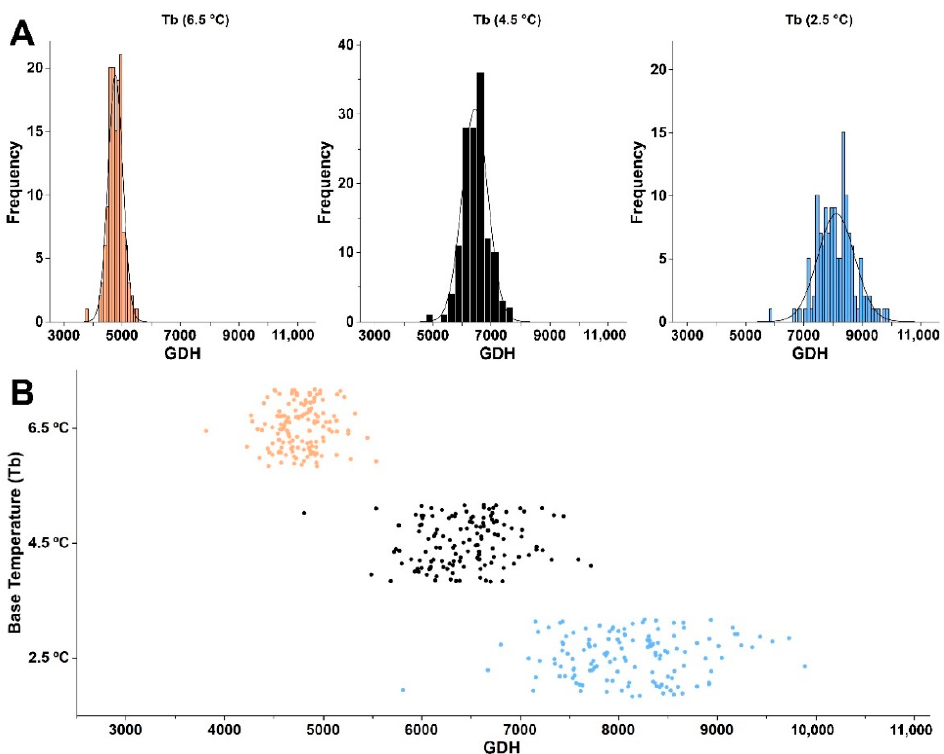
Figure 4. Heat requirement distribution [histogram ( A ) and dot plot ( B )] in the U.S. peach germplasm under 2.5 (orange), 4.5 (black) and 6.5 (blue) °C base temperature (Tb) in Richardson’s model. Data represent the best linear unbiased prediction (BLUP) values for growing degree hours (GDH) across eight years (2014–2021).